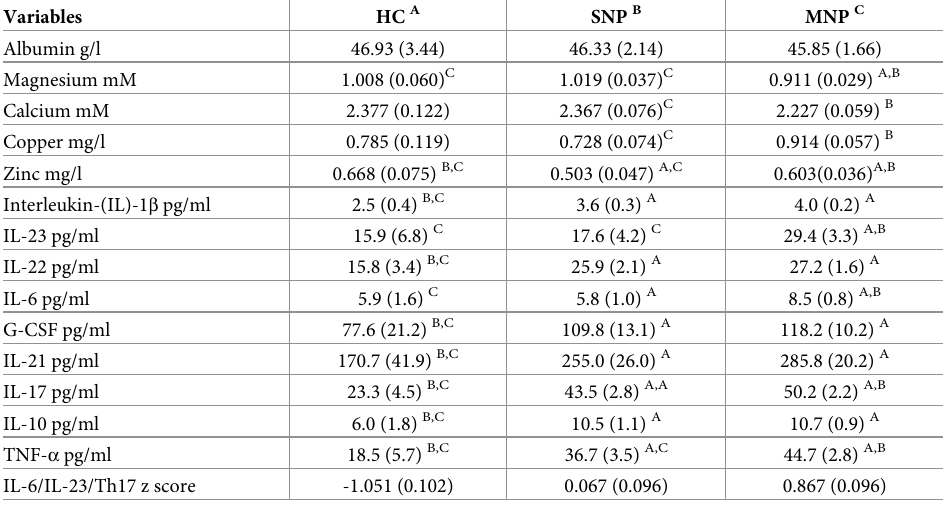
Table 3. Model-generated estimated marginal means of the different immune markers in healthy controls (HC) and patients with schizophrenia divided into those with major (MNP) and simple (SNP) neurocognitive psychosis.